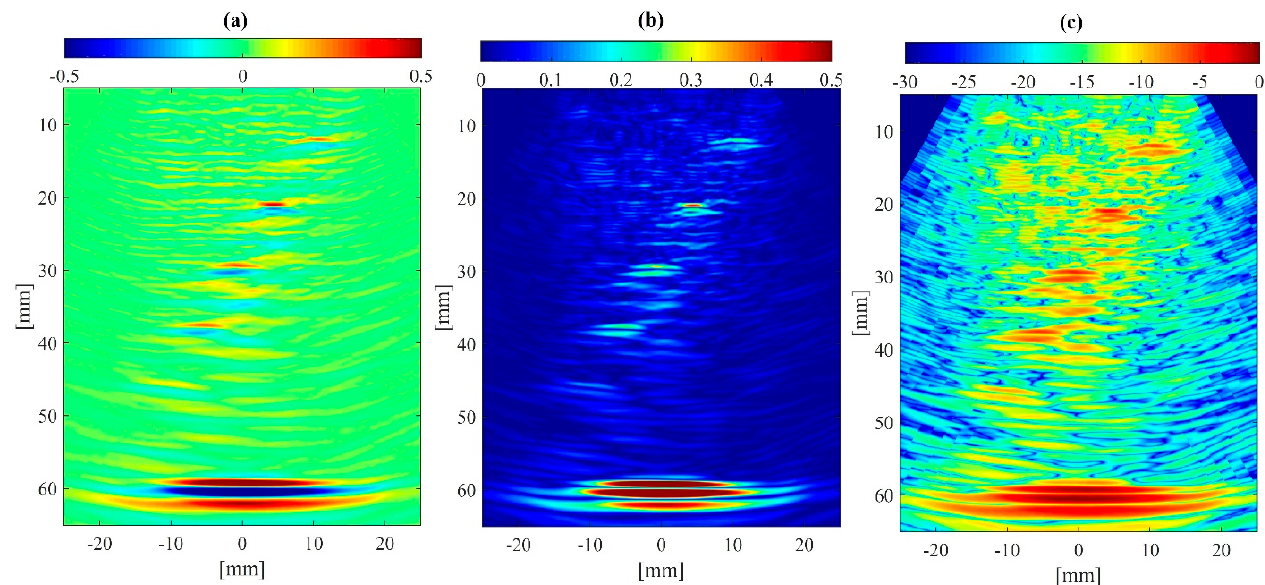
Figure 7. TFM Image of the CFRP sample, obtained using a linear chirp coded excitation signal, and the pulse-compression procedures. The images visualize ( a ) the full-wave amplitude, ( b ) the energy, and ( c ) the energy in the dB scale of the echo signal.